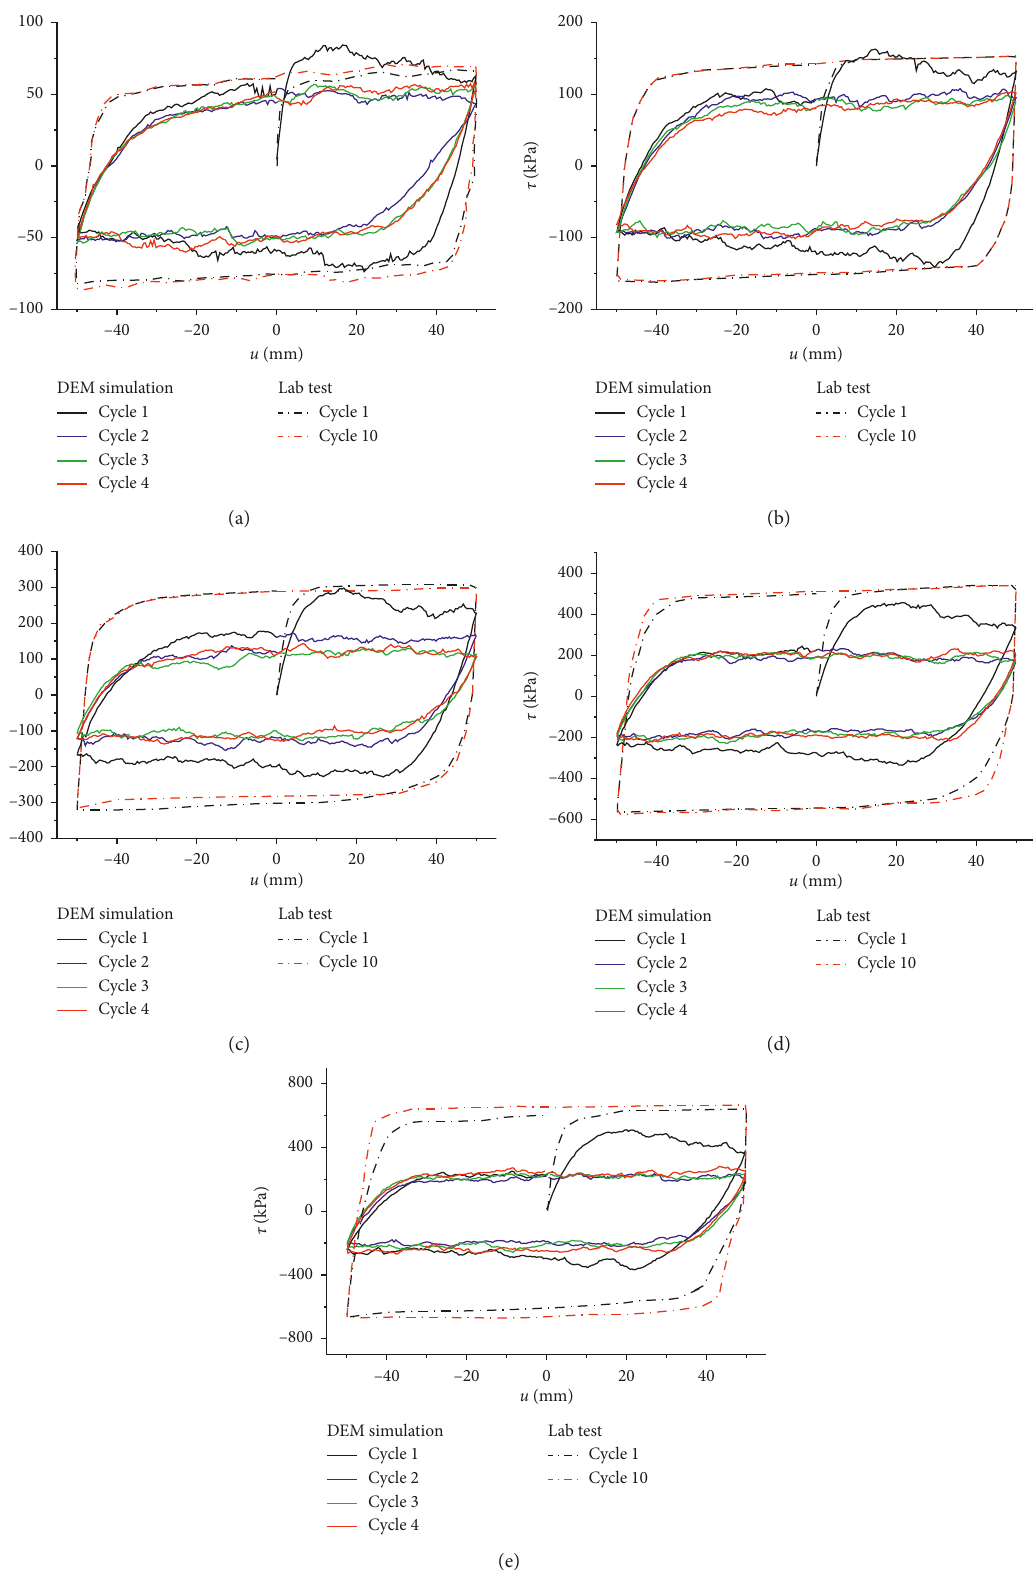
Figure 6: Comparison between results of DEM simulation with breakable agglomerates and identical composite pattern and laboratory interface test results in terms of shear displacement against shear stress under constant normal stress: (a) 100kPa; (b) 200kPa (SY_2_15); (c) 400kPa (SY_4_15); (d) 700kPa (SY_7_15); (e) 800kPa. τ , shear stress of interface; u , shear